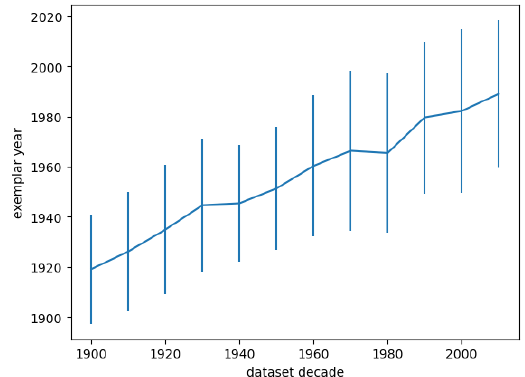
Figure 11. Distribution over the year associated with the marginal coresets for each decade. Plot shows weighted mean ± weighted standard deviation.